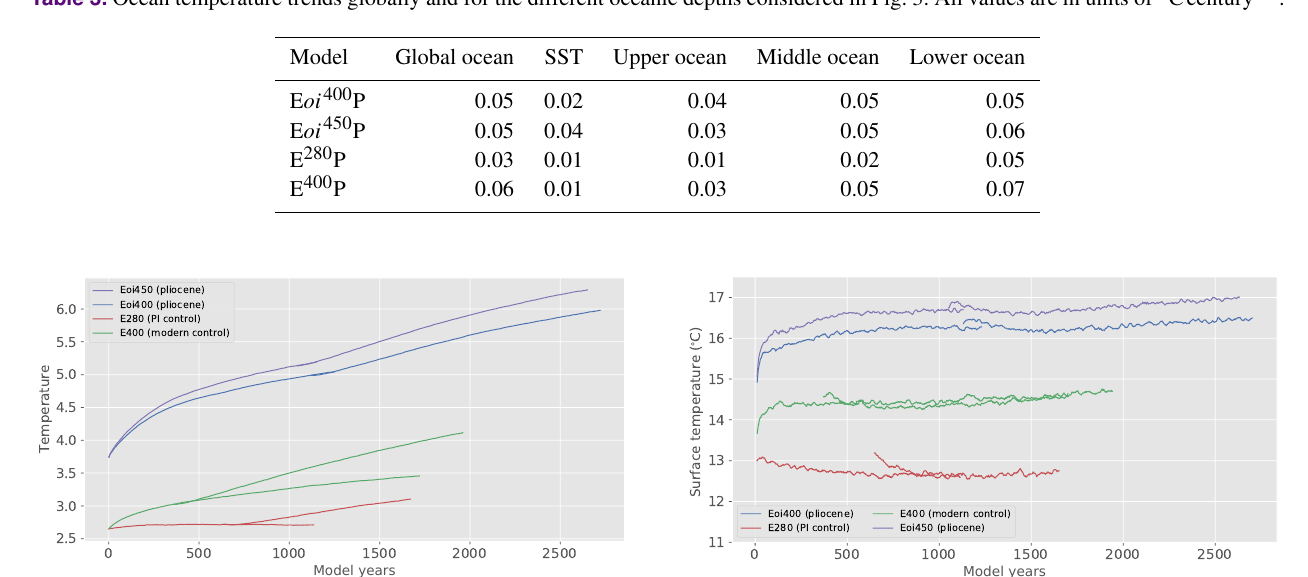
Table 3. Ocean temperature trends globally and for the different oceanic depths considered in Fig. 3. All values are in units of ◦ Ccentury − 1 .